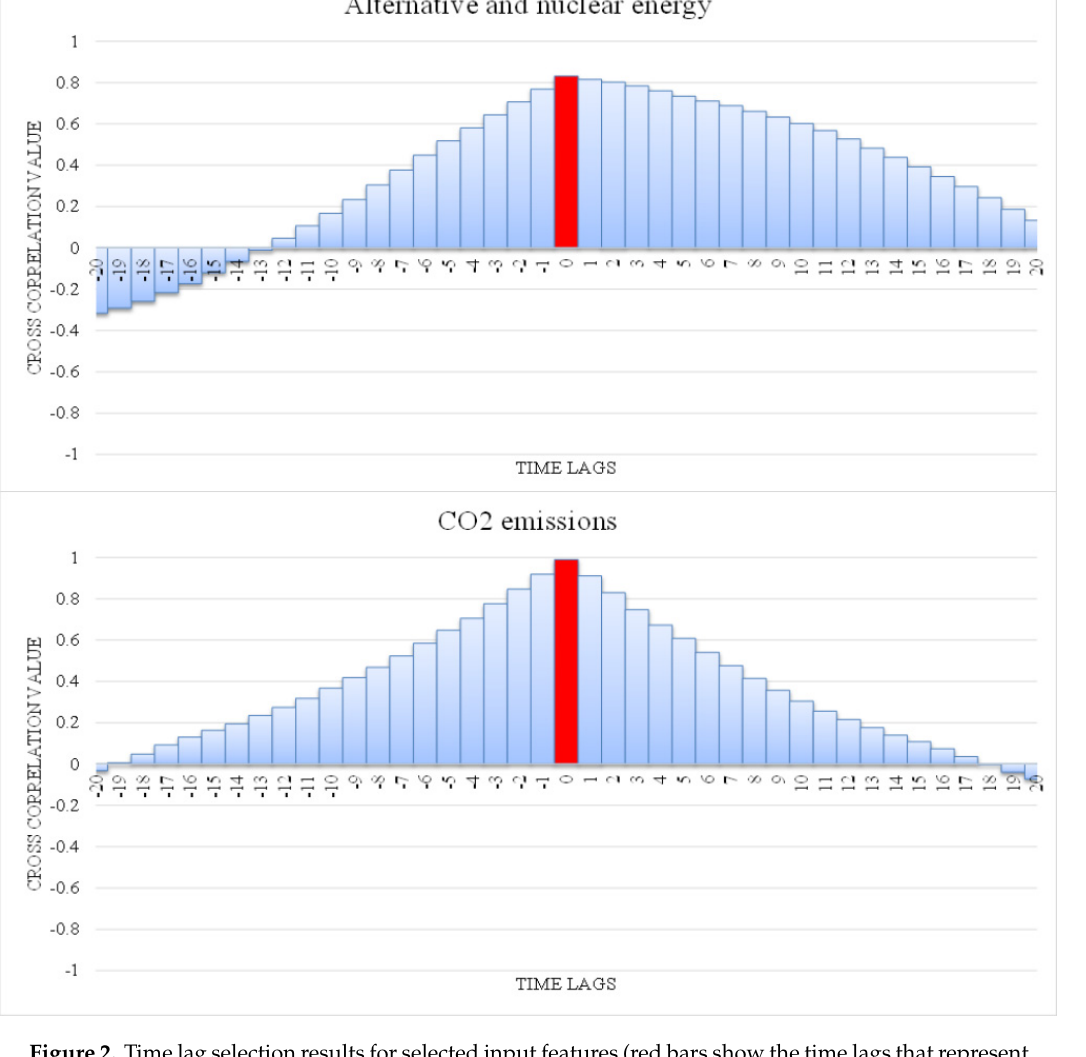
Figure 2. Time lag selection results for selected input features (red bars show the time lags that represent higher correlation among the feature versus target attribute for each input feature).